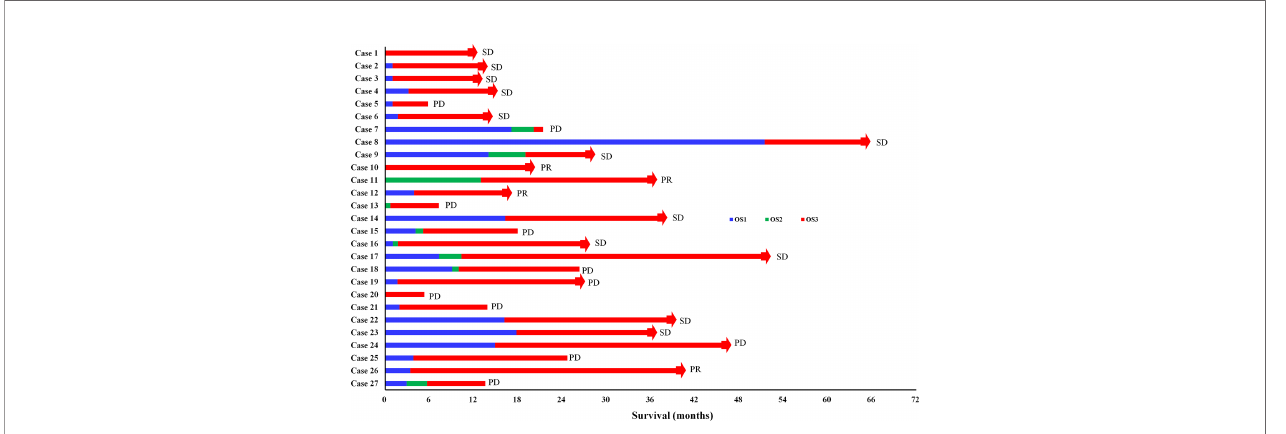
FIGURE 4 | The treatment process of 27 DMPM patients. OS1: the time interval from surgery or chemotherapy to death or disease progression (PD); OS2: the time interval from second-line treatment to death or PD; OS3: the time interval from apatinib treatment to death or PD; CR, complete response; PR, partial response; SD, stable disease; The red bars with square end indicate patient death, and those with arrow end indicate patient still alive on apatinib treatment.